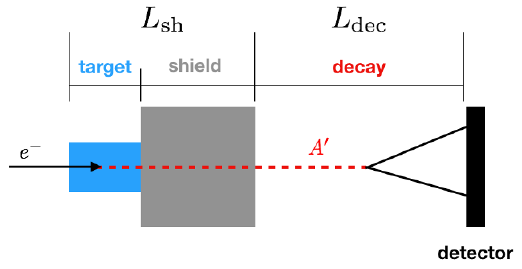
Figure 17 . Schematic of an electron beam dump experiment like SLAC